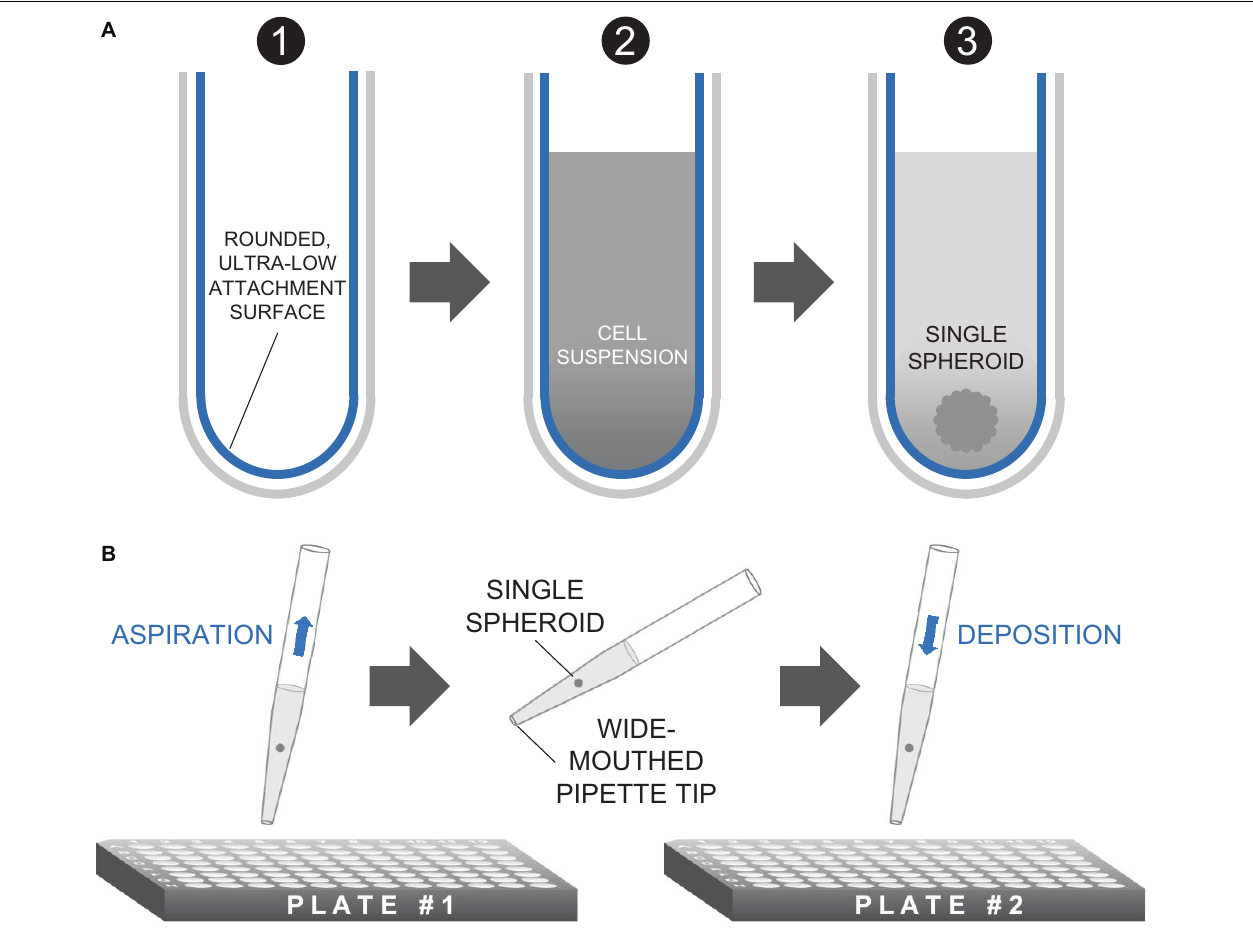
FIGURE 2 | Method of spheroid formation. (A) Microplates featuring rounded, ultra-low attachment surfaces facilitate the formation of a three-dimensional spheroid of cells from a homogeneous cell suspension. (B) Spheroids are transferred in medium via standard micropipettors fitted with wide-mouthed